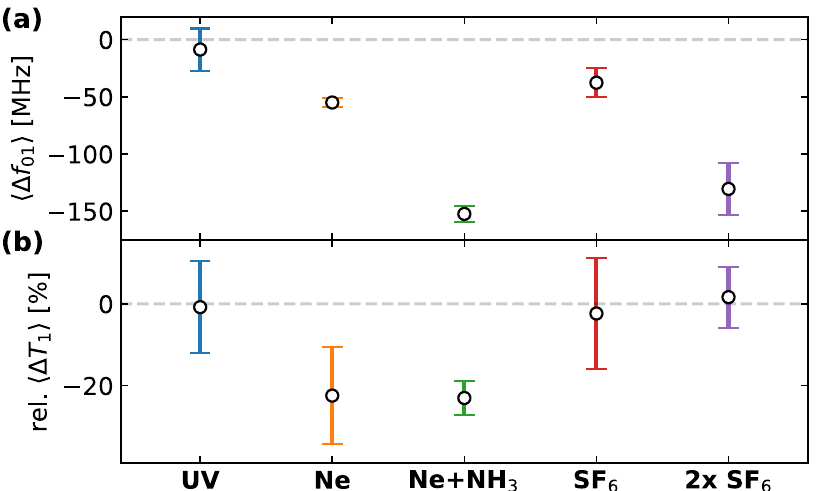
Fig. 5 Qubit frequency tuning. Changes in qubit frequency ( a ) and T 1 ( b ) at the sweet spot after ion milling treatments as described in the Methods section. Circles are mean values and error bars indicate one standard